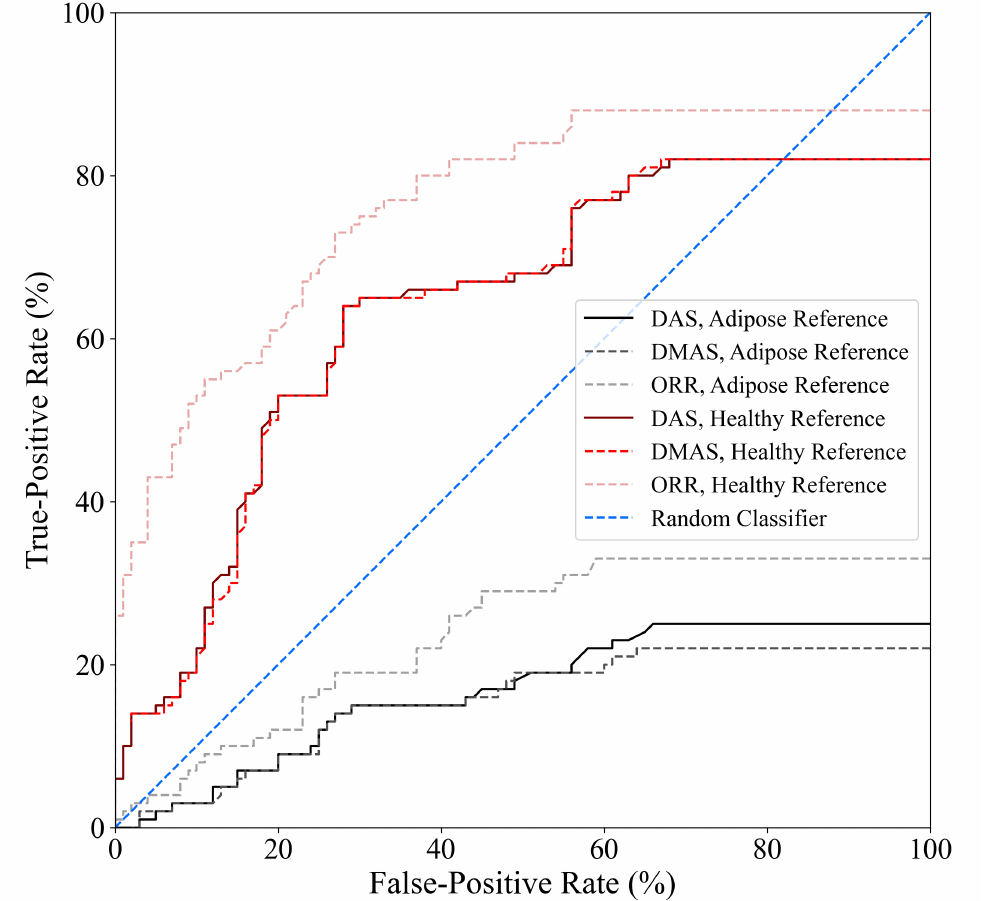
Figure 6. ROC curves of the DAS, DMAS, and ORR algorithms when either adipose-only phantom scans or healthy (adipose and fibroglandular) phantom scans are used as references for artifact suppression, determined using one thousand linearly spaced SCR thresholds between 0 and 30 dB. The ORR outperformed the DAS and DMAS beamformers for all SCR